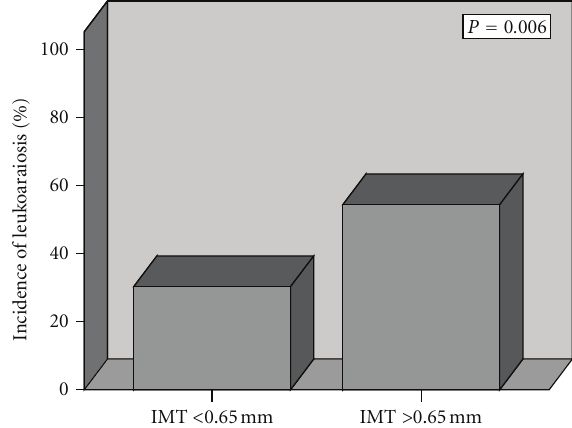
Figure 2: Prevalence (%) of leukoaraiosis by median of intima-media thickness (IMT). ∗ P computed by χ 2 analysis.